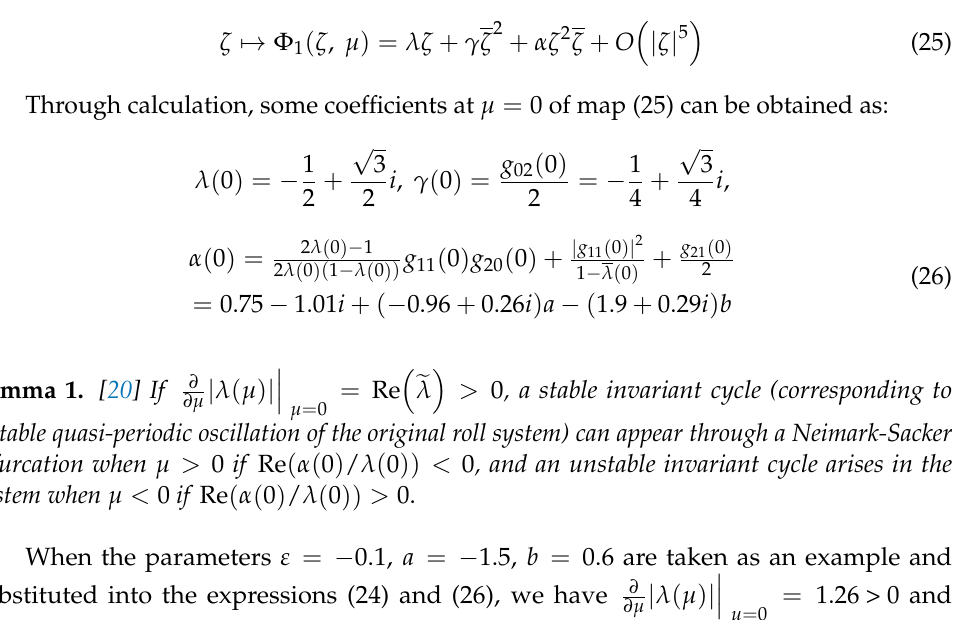
Figure 2. When µ > 0, the fixed point loses its stability, and a stable invariant cycle appears through Neimark-Sacker bifurcation, as is shown in the left-hand sketch of Figure 3, which corresponds to a stable quasi-periodic oscillation of the original roll system (6) as shown in the right-hand sketch of Figure 3.